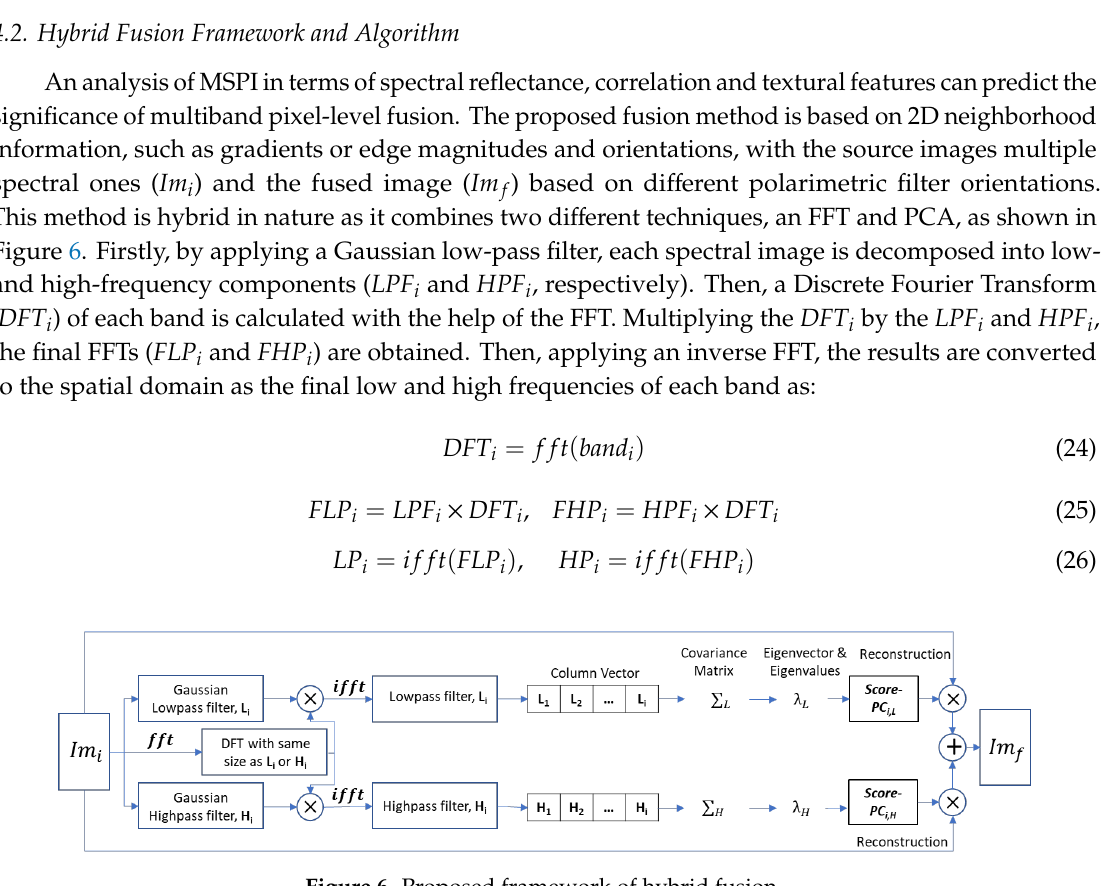
Figure 6. Proposed framework of hybrid fusion.